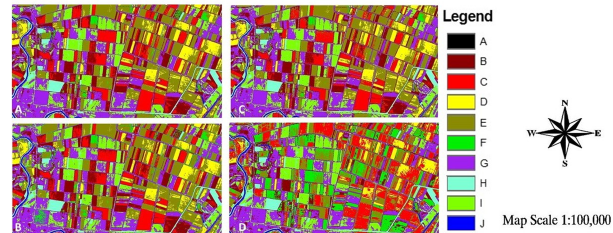
Figure 2.Classified images (Analysis A, B, C, D)